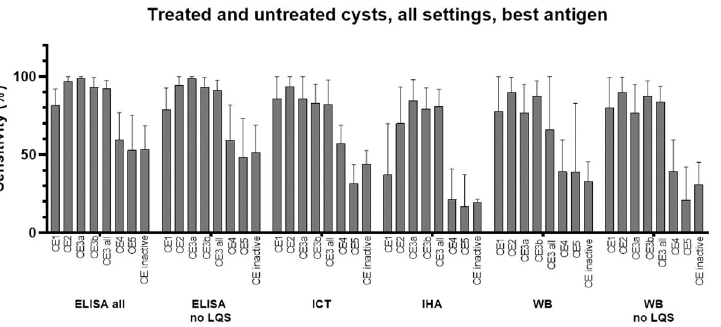
Fig 4. Sensitivity (%) of ELISA tests for the diagnosis of hepatic CE cysts, irrespective of previous treatment and setting. “CE3 all” = data from CE3a + CE3b + CE3 not divided into CE3a and CE3b. “CE inactive” = data from CE4 + CE5 + CE4 and CE5 not divided into CE4 and CE5. LQS = Low Quality Studies. In case more than one assay per type was investigated in the same paper (e.g. more than one ELISA test), the one with the best sensitivity was used for the meta-analysis. Error bars represent 95%